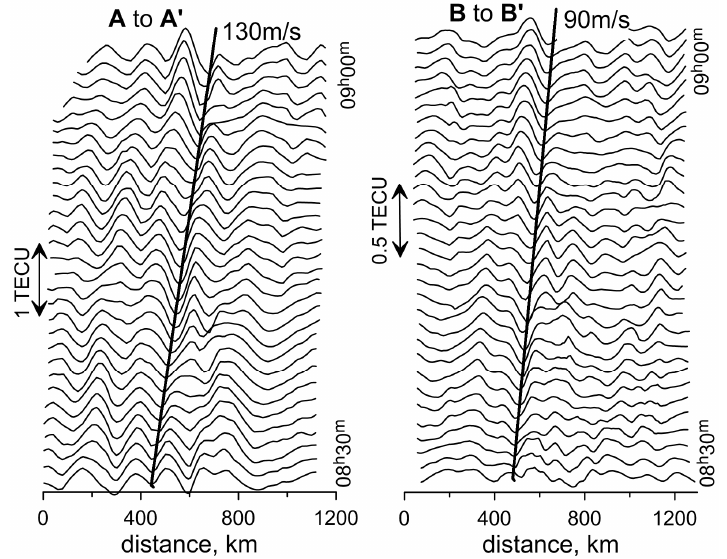
Figure 10. Profiles of TEC variations along the line A-A’ in Figure 7 from 08h30m to 09h00m on 13 March 2013 ( left ) and along the line B-B’ from 08h30m to 09h00m on 13 March 2015 ( right ), in the form of a “waterfall”. The bold line shows the wave pattern trajectory.